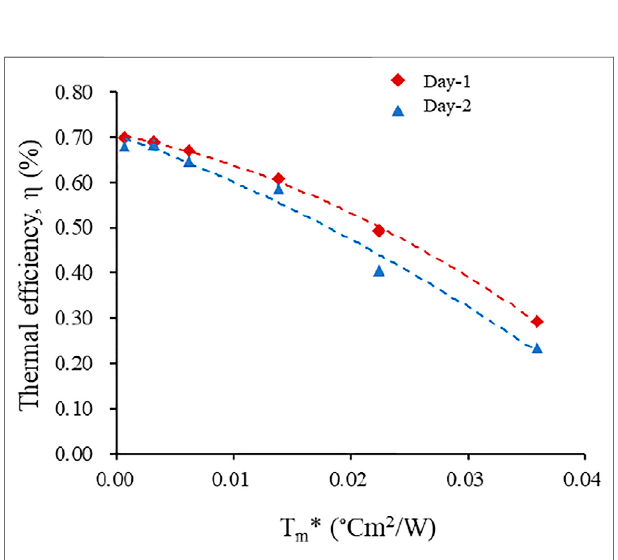
FIGURE 10 | Experimental ef fi ciency of the CPC collector operating in thermosyphon mode.